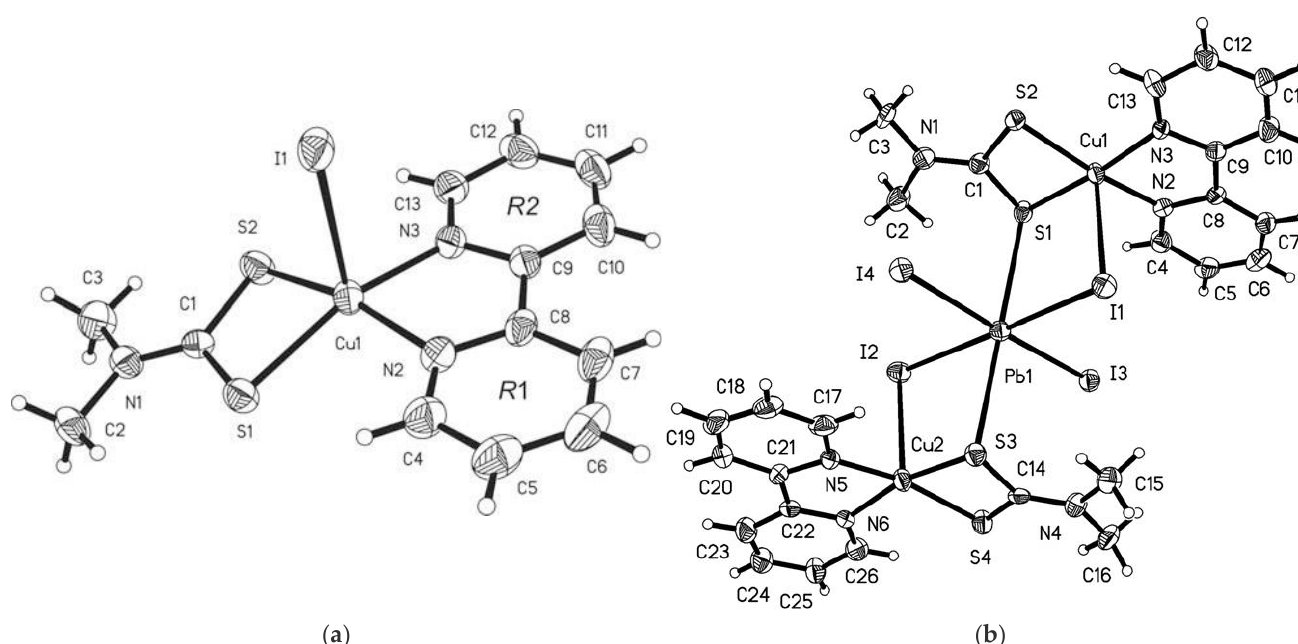
Figure 21. The molecular structures of ( a ) [CuI(S 2 CNMe 2 )(2,2 ′ -bipy)] and ( b ) PbI 4 [Cu(S 2 CNMe)(bipy)] 2 . Reproduced with permission from [154]. Copyright 1997 De Gruyter and from [158].